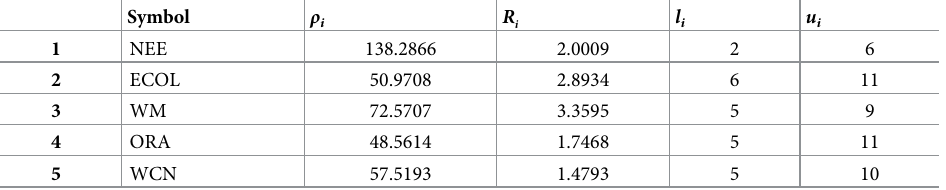
Table 1. Information on environmental